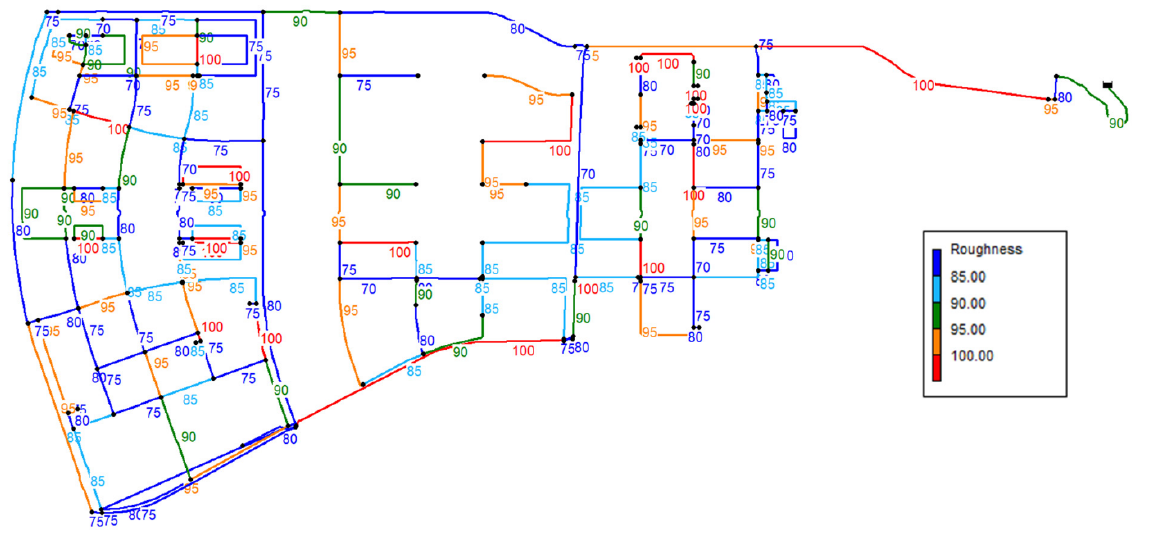
Figure 6. EPANET model of the Cheongna WDN, highlighting the optimal Hazen–Williams rough- ness coefficient C value distribution determined by the HS algorithm based on the original set of pipe diameters.